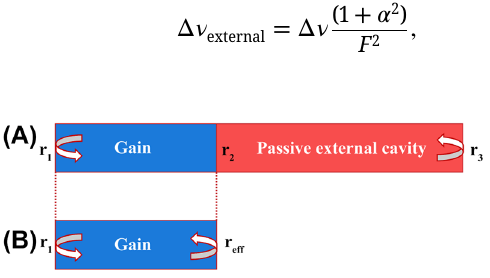
Figure 9: (A) External cavity model. (B) Equivalent cavity surface